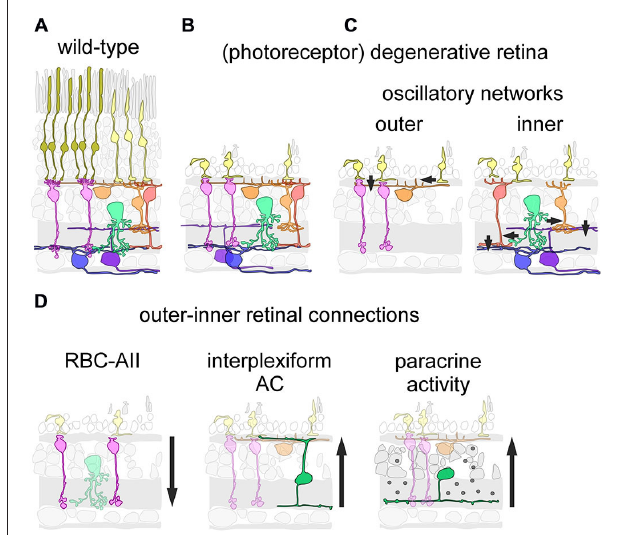
FIGURE 1 | Inner and outer oscillations in the degenerative mouse retina. (A,B) Schematic drawing showing cellular organization in the healthy (wild-type) (A) and the photoreceptor-degenerative retina (B) . Note that in the absence of rods, some cones still persist but lack light-sensitive outer segments. (C) Neuronal circuits underlying outer (left) and inner (right) spontaneous activity in the degenerative retina. (D) Putative pathways connecting the inner to the outer retina. The rod bipolar cell (RBC) may relay outer retinal activity to the inner retina via synapses with the AII amacrine cells (AII) (left). Interplexiform amacrine cells make synaptic contacts in the outer retina, and thus could relay inner retinal activity to the outer retina (middle). Paracrine release of neuromodulators by amacrine cells could act as a “diffuse” inner-to-outer-retina pathway (right). (C,D) Only relevant neuron types/classes are depicted; arrows indicate direction of main signal